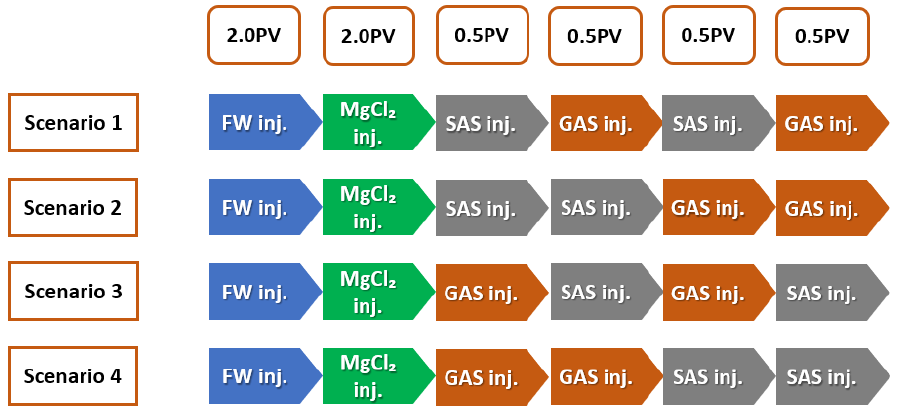
Figure 12. SWAF injection Scenarios (MgCl 2 + Oil Type-A); the effect of crude oil type (Type-A and Type-B) at different smart-water ( SW )